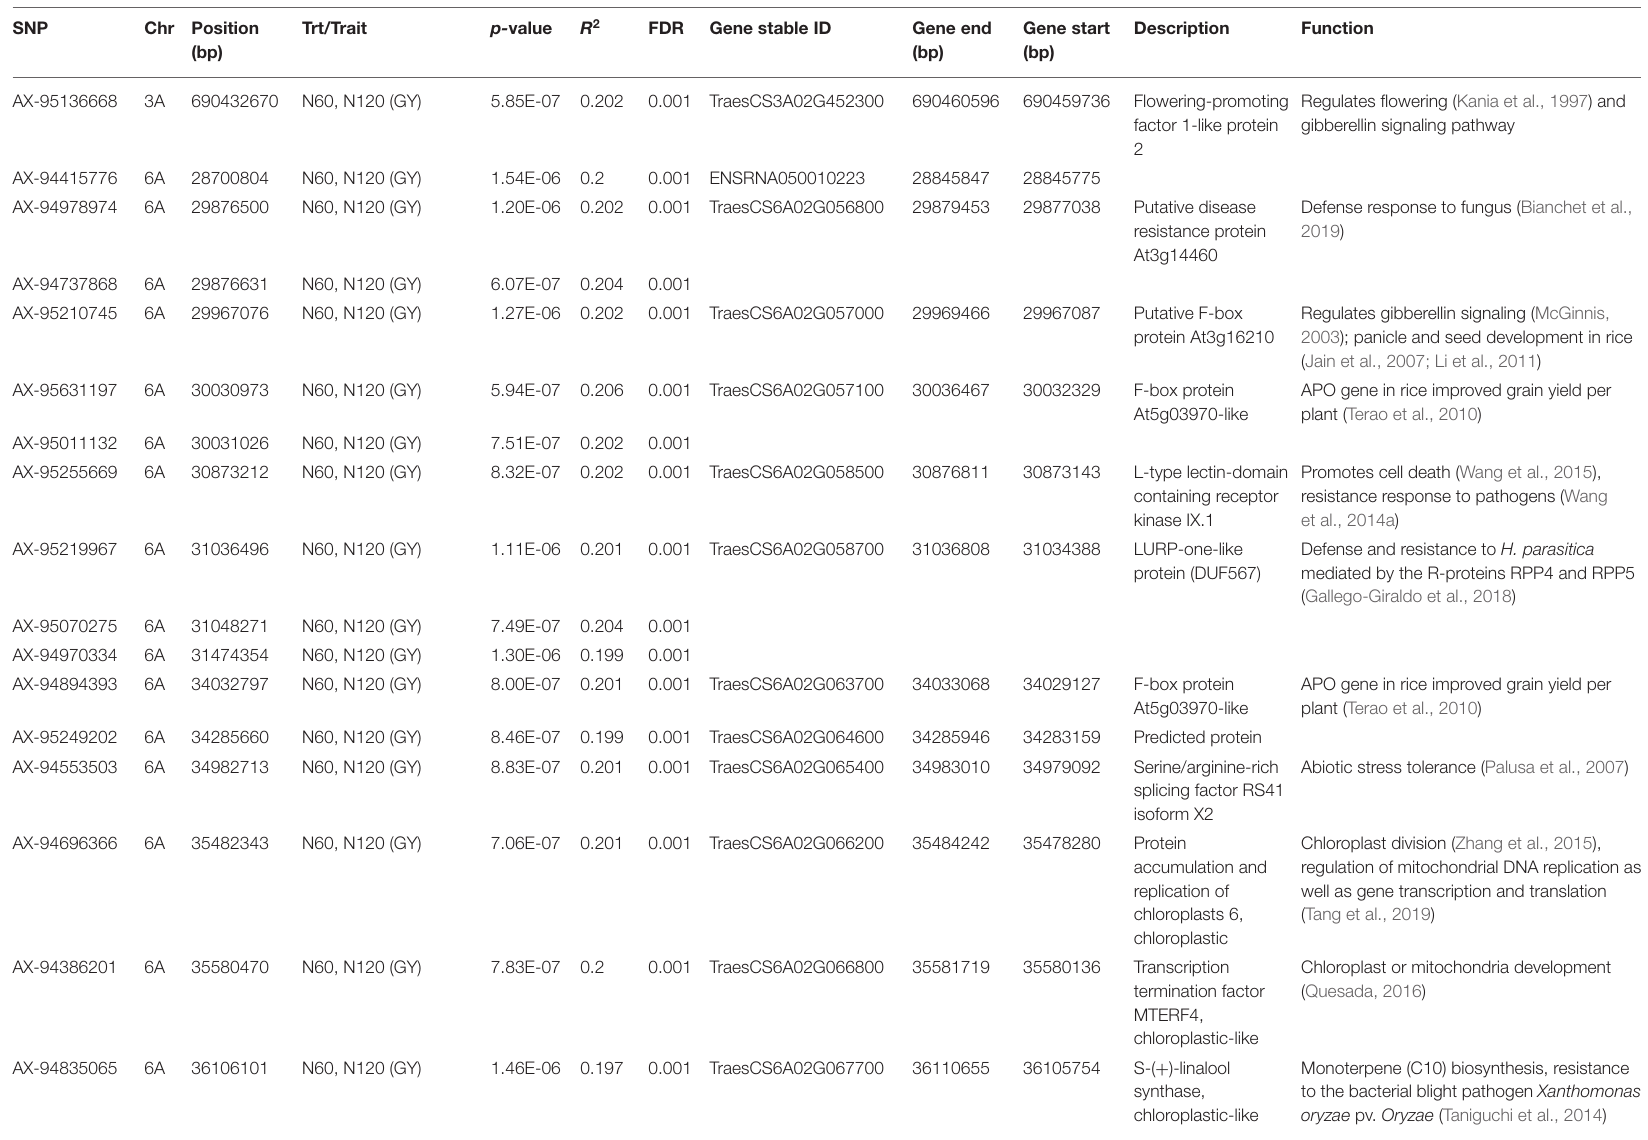
TABLE 3 | The significant marker-trait associations (MTAs) and putative candidate genes identified across different treatments for the NUE-related, root, plant morphological, yield, and yield-related traits in a genome wide association study (GWAS) conducted on nested synthetic wheat introgression libraries. SNP Chr Position